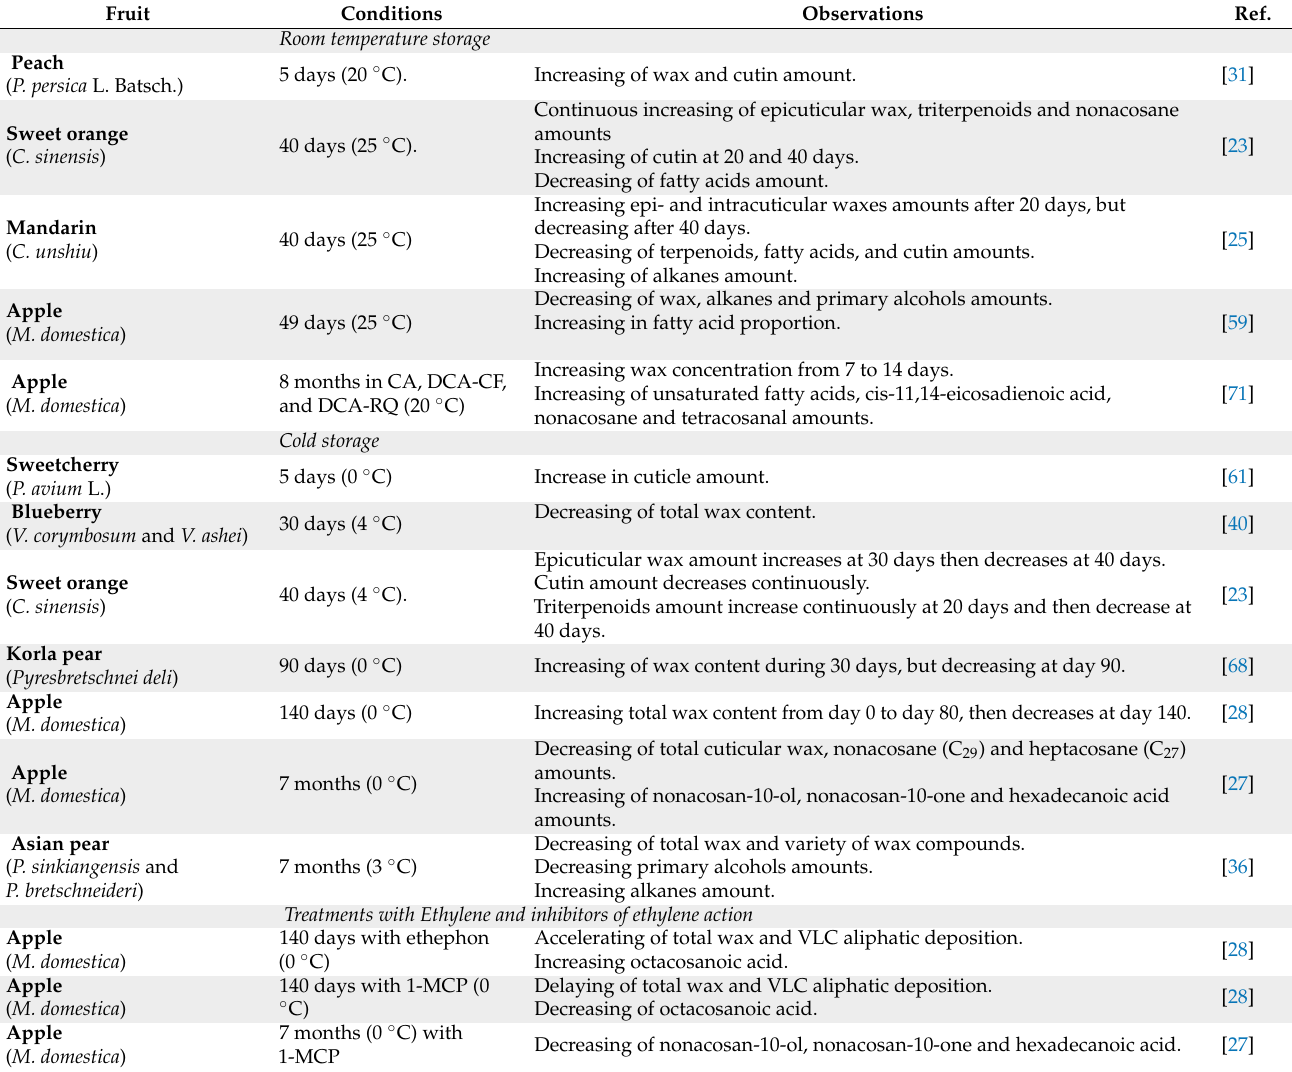
Table 3. Cuticle composition changes in response to different postharvest storage conditions of fleshy